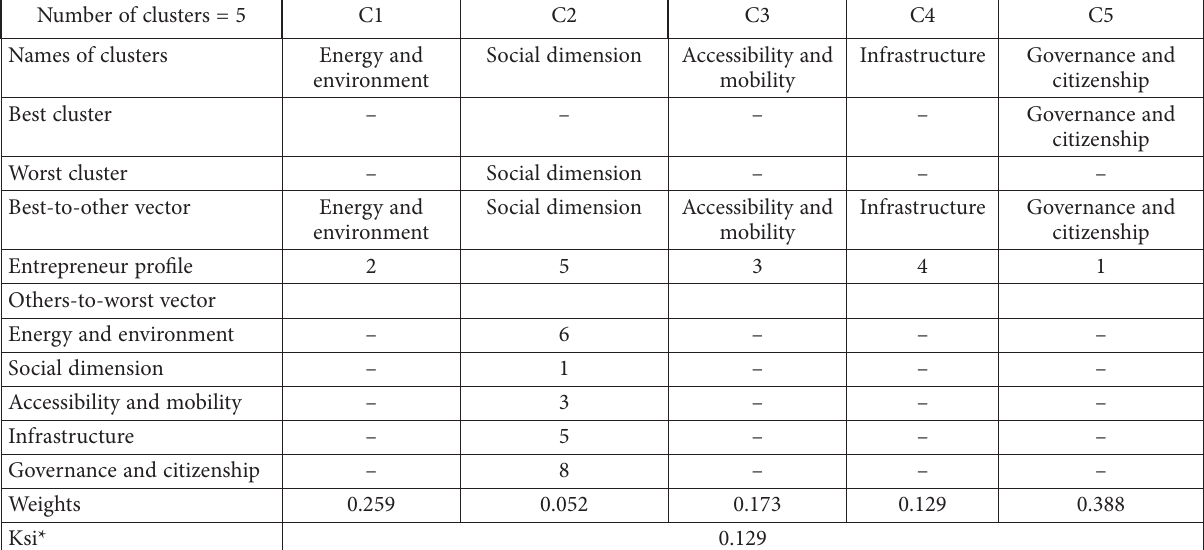
Table 2. Best-worst method application to